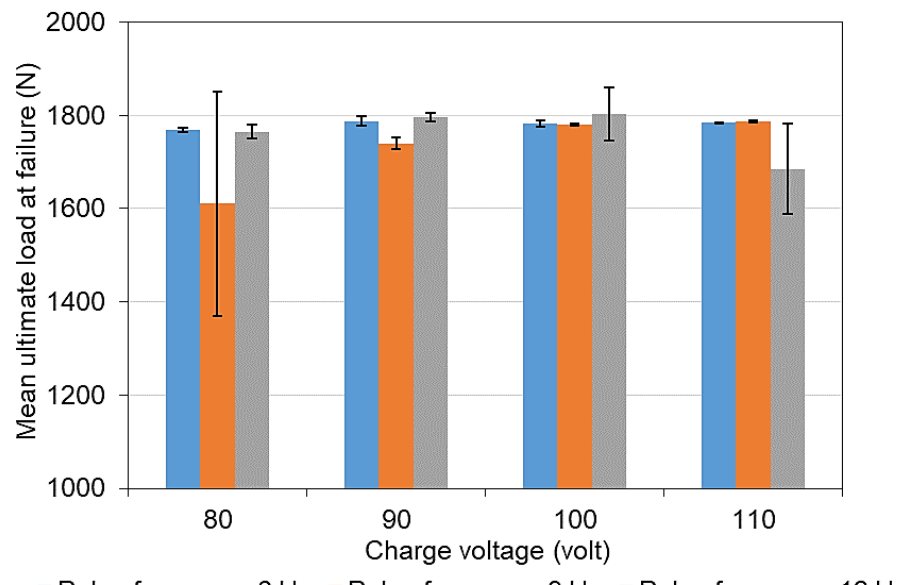
Figure 15. Effect of laser parameters on ultimate load at failure ±SD (length of welding 10 mm).